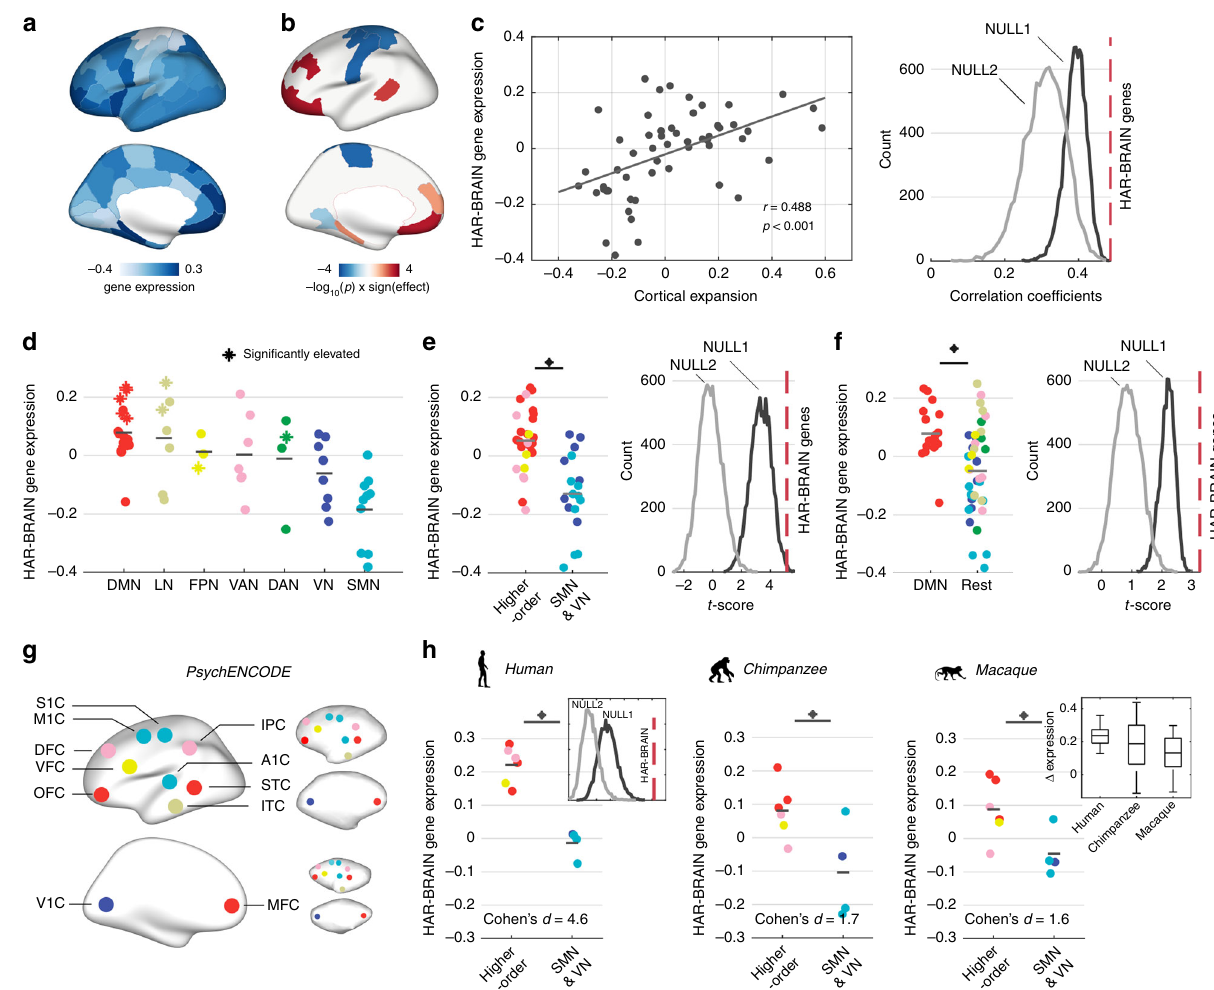
Fig. 3 HAR-BRAIN gene expression. a Cortical gene expression of HAR-BRAIN genes. b Cortical maps of the signi fi cance level obtained by permutation tests, comparing expressions of HAR-BRAIN genes to equally sized random gene-sets taken from BRAIN (NULL1) and ECE genes (NULL2). c Association between the gene expression pro fi le of HAR-BRAIN genes and normalized cortical expansion between human and chimpanzee (left). The correlation coef fi cient is signi fi cantly higher than NULL1 and NULL2 (both p < 0.001, two-sided, permutation test; right). d HAR-BRAIN gene expression within each of the seven functional networks ranked in descending order of the mean expression. Asterisks (*) indicates signi fi cantly upregulated regions as in panel b . e HAR-BRAIN gene expression in cognitive networks (DMN, FPN, and VAN) versus the SMN and VN (left), with permutation results demonstrated in the right panel (two-sided p = 0.003 and p < 0.001 for NULL1 and NULL2, respectively). f HAR-BRAIN gene expression in the DMN versus the rest of the cortex (left), with permutation results demonstrated in the right panel (two-sided p < 0.001 for both NULL1 and NULL2). g Species-homologous brain areas as presented in the PsychENCODE dataset for the human (left), chimpanzee (upper right), and macaque (lower right). h Normalized expression levels of HAR-BRAIN genes in regions of higher-order networks compared to areas of the SMN/VN in humans ( p < 0.001, two-sample t test). Largest differences in gene expression are found in humans, with chimpanzees in second place, followed by macaques ( p = 0.002, Jonckheere-Terpstra test). Asterisks (*) indicates two-sided p < 0.05, FDR corrected. Central marks denote the mean gene expression. Boxplot center, median; box = 1st − 3rd quartiles (Q); lower whisker, Q1 – 1.5 × interquartile range (IQR); upper whisker, Q3 + 1.5 × IQR. Colors indicate the assignment of functional networks, as in Fig. 2b.